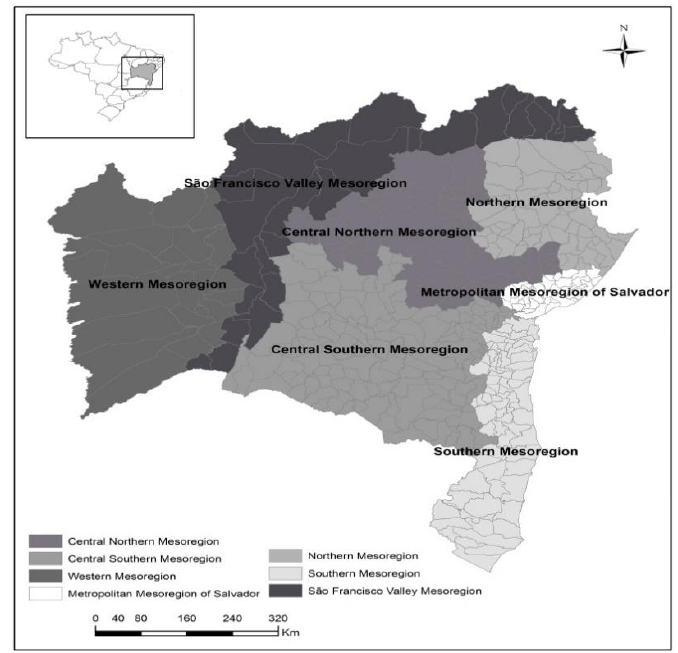
Int. J. Environ. Res. Public Health 2019 , 16 , x Figure 1. Distribution of mesoregions, Bahia, Brazil, 2017. Figure 1. Distribution of mesoregions, Bahia, Brazil, 2017.